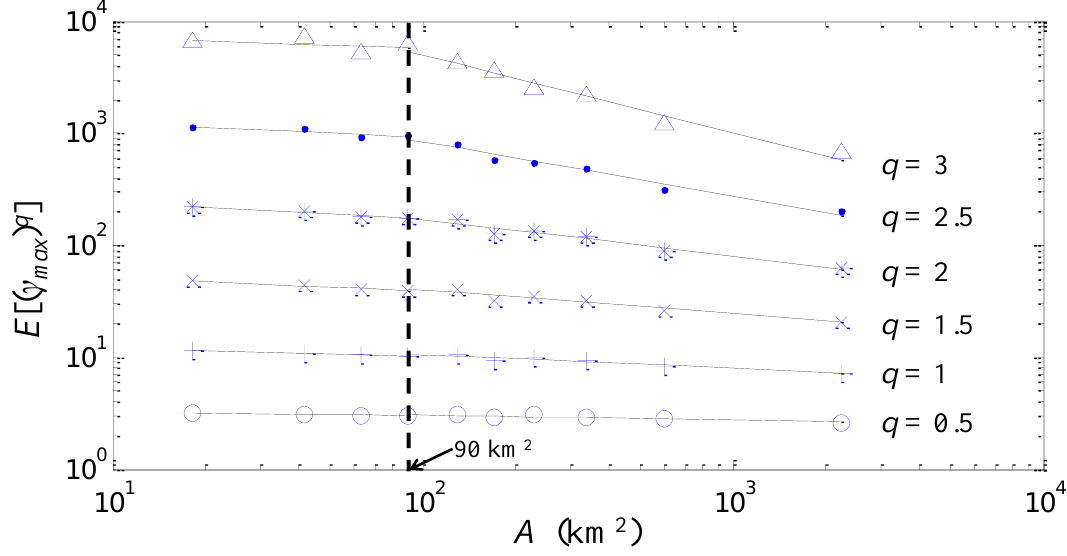
(cid:104) (cid:105) = = 𝑚𝑎𝑥 ( γ max ) q of the amplification factor γ max = 𝑚𝑎𝑥